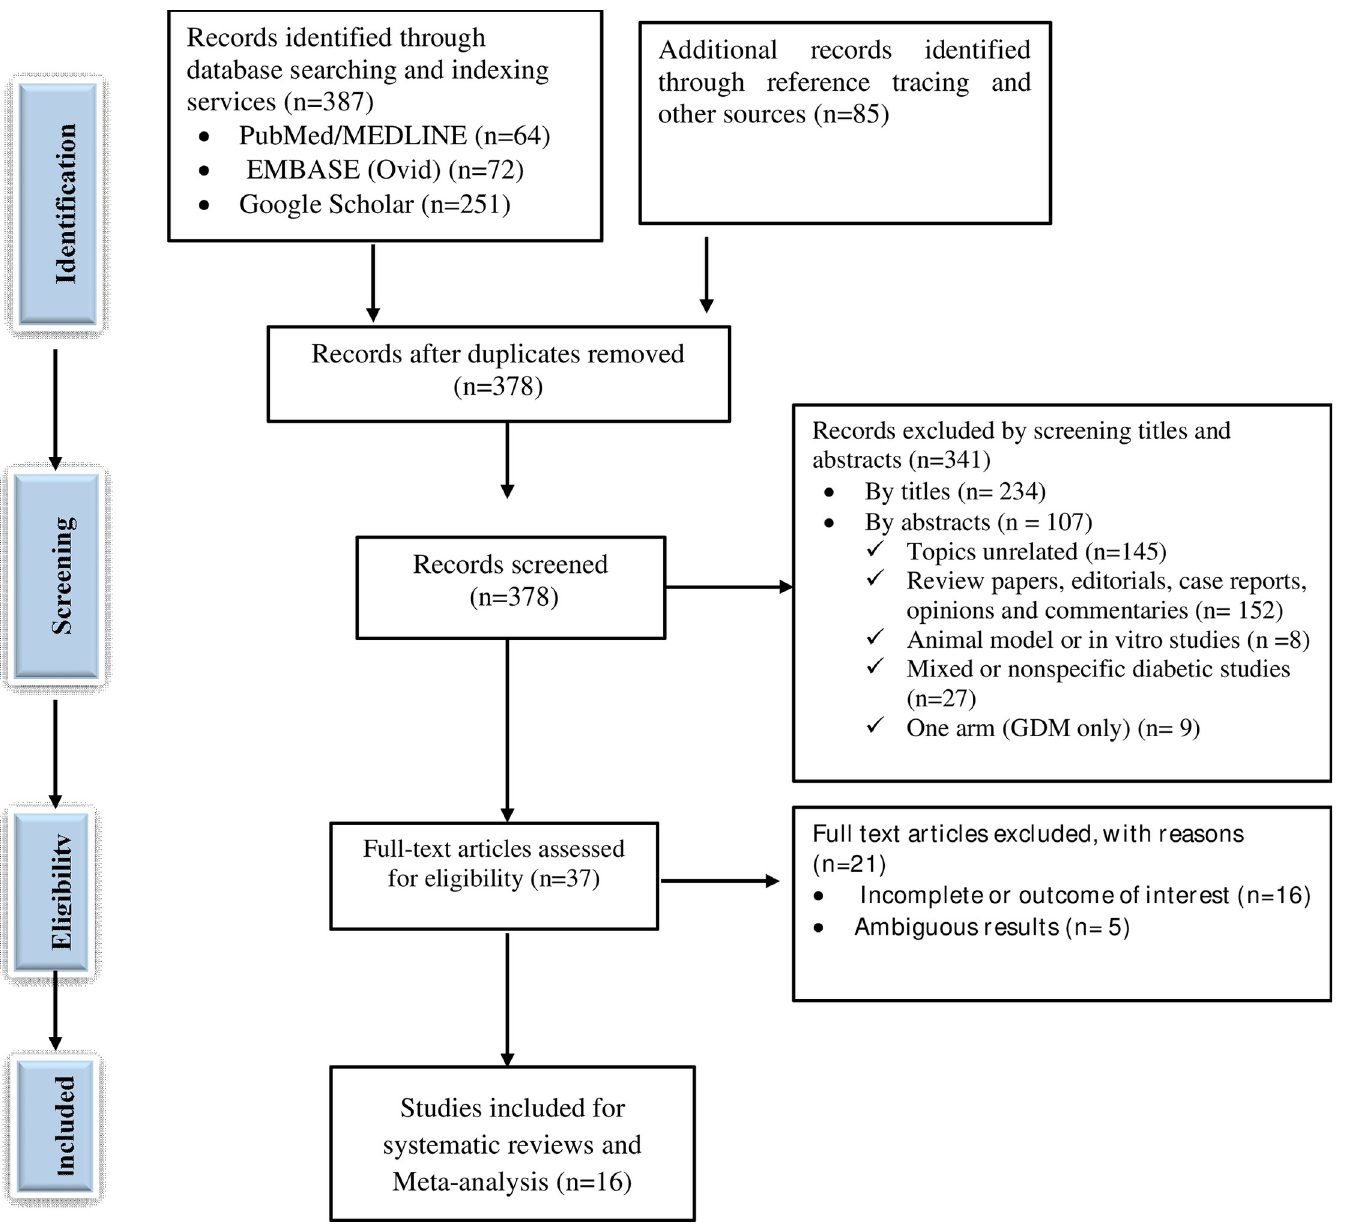
Fig 1. PRISMA flow diagram showing the selection process of retrieved